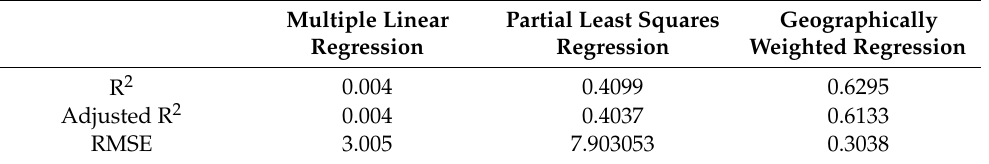
Table 2. Comparison of Multiple Linear Regression (MLR), Partial Least Squares (PLS) regression and Geographically Weighted Regression (GWR) for analysis of GF-5 data and field-measured Au content.